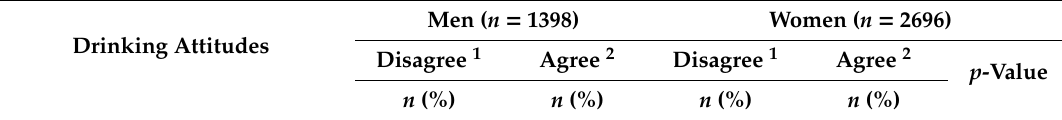
Table 2. Employees’ drinking attitudes, stratified by